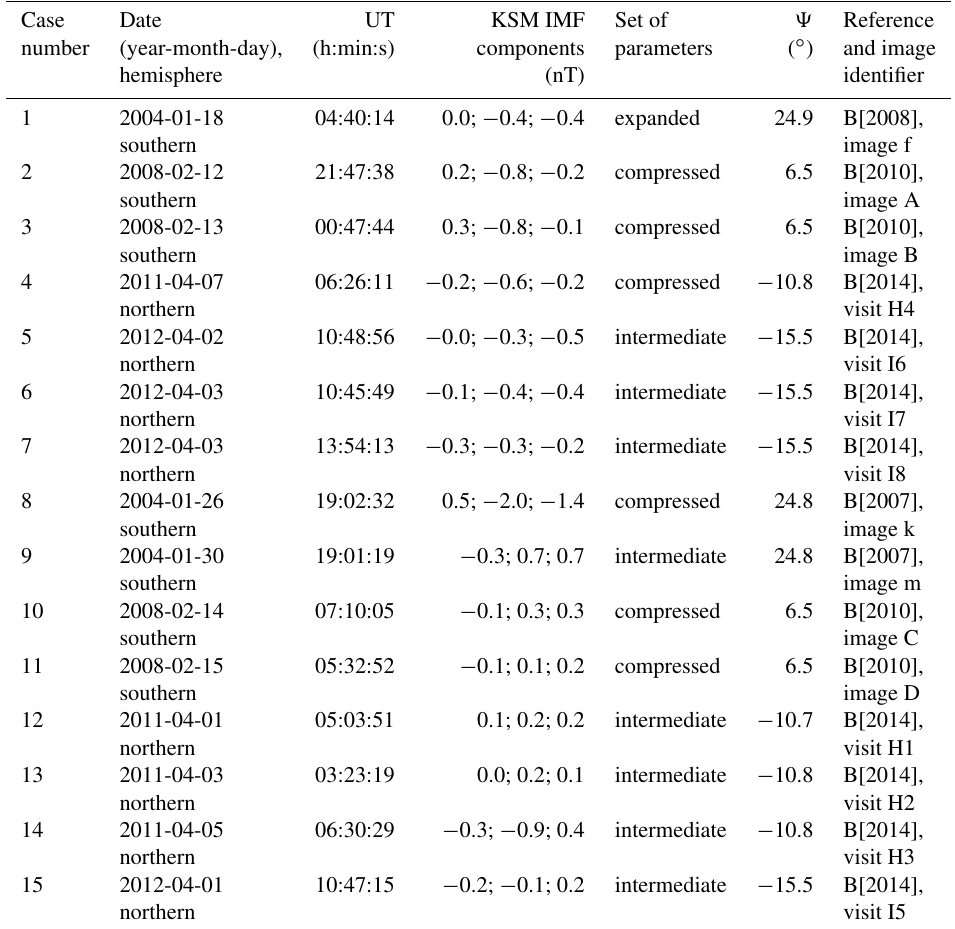
Table 1. The case numbers of the UV images considered in this paper are listed together with the date, the hemisphere in which the aurora was observed, UT, KSM IMF components, magnetospheric state corresponding to the set of model parameters employed, tilt angle (cid:57) , and the reference and image